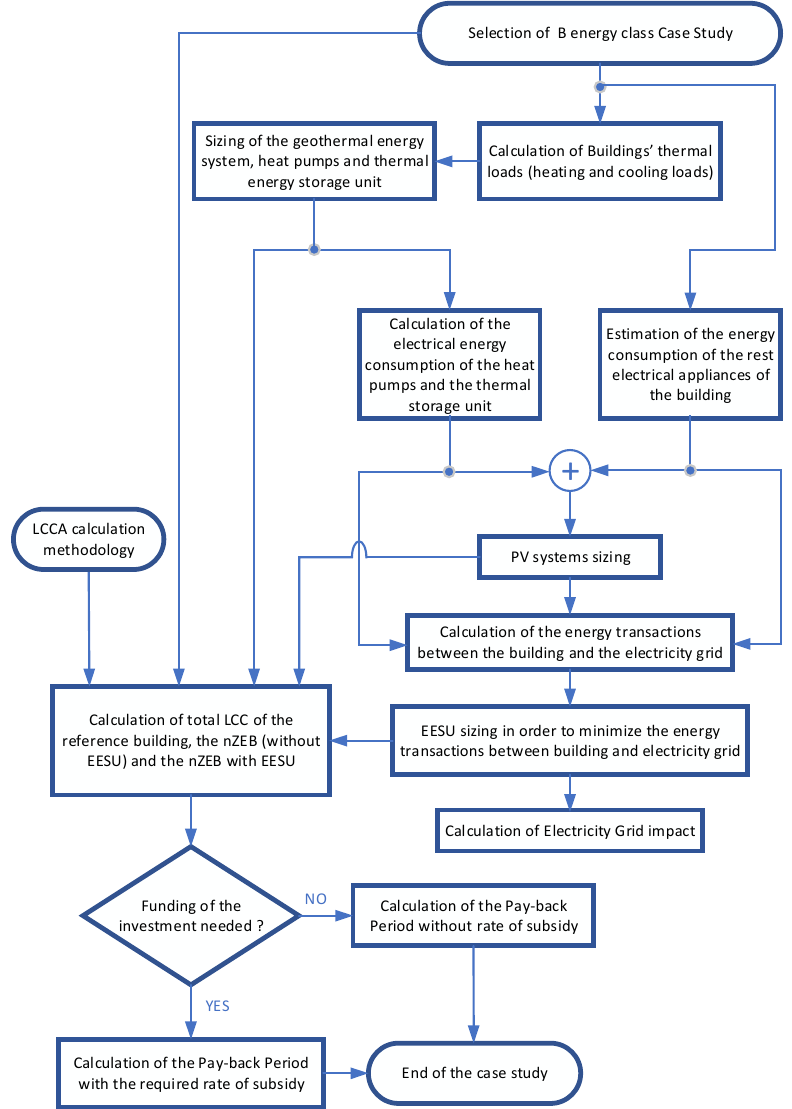
Figure 2. Flow diagram of the methodology and steps of this paper.